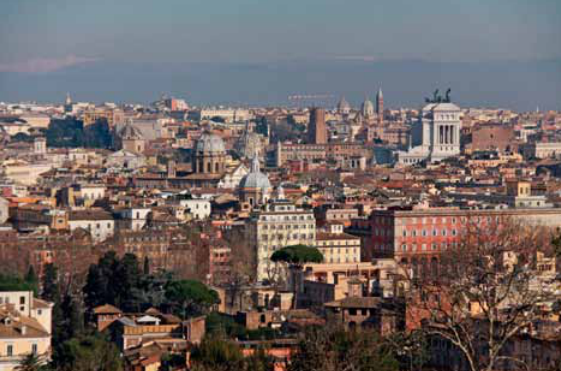
fig. 10. The changing of london silhouette. The contrast of modern and historic architecture